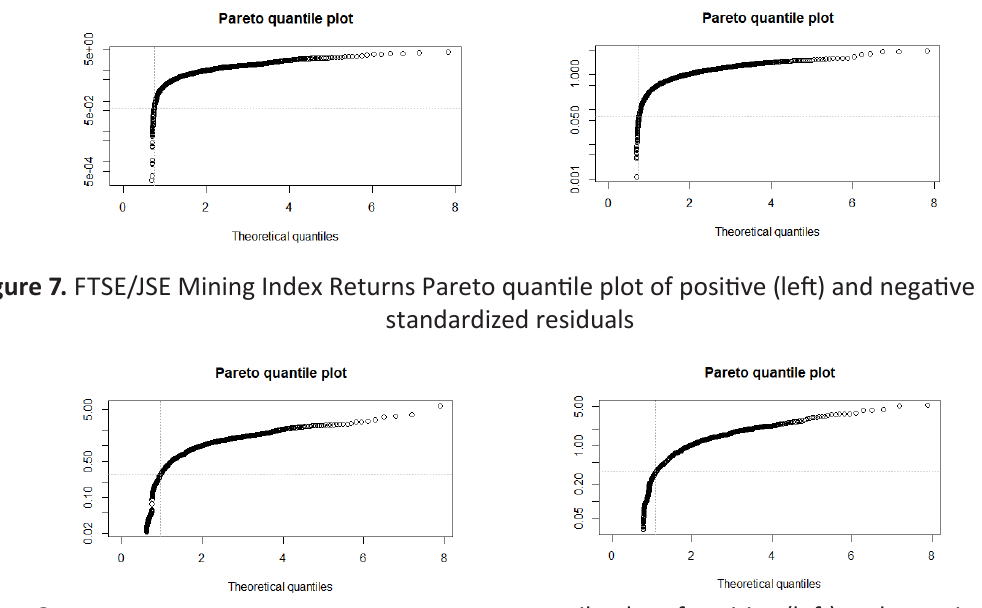
Figure 8. USD/ZAR Exchange Rate Returns Pareto quantile plot of positive (left) and negative (right) standardized residuals